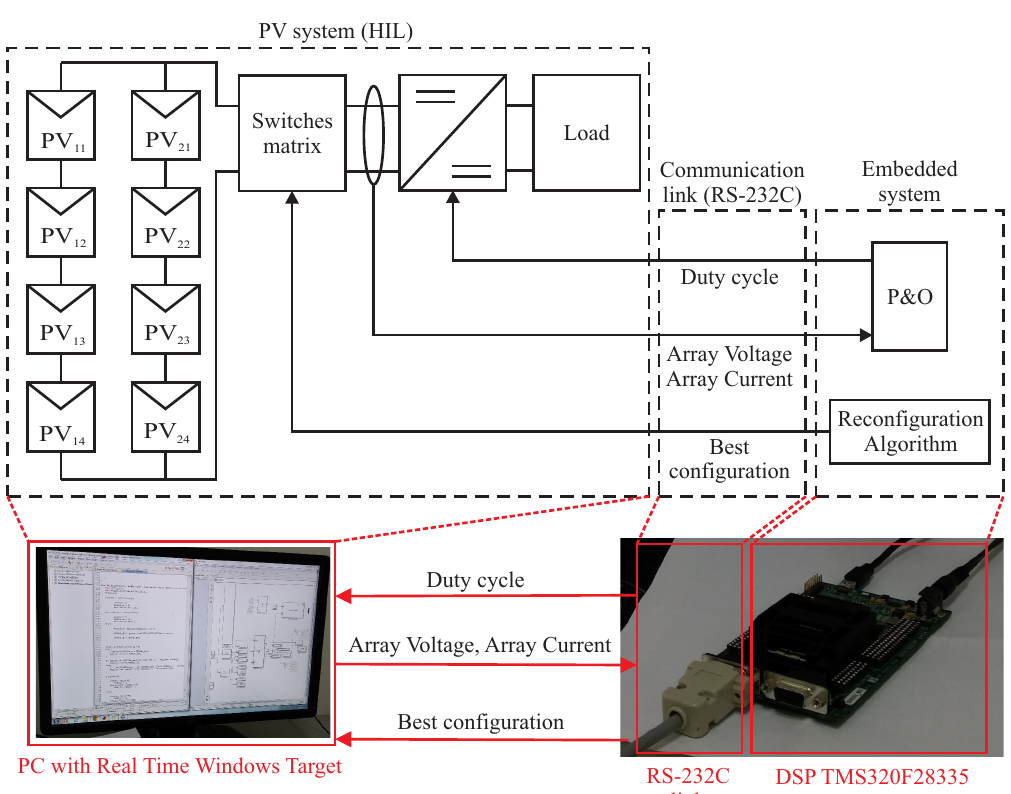
Figure 8. Block diagram and hardware implementation of the proposed simulation